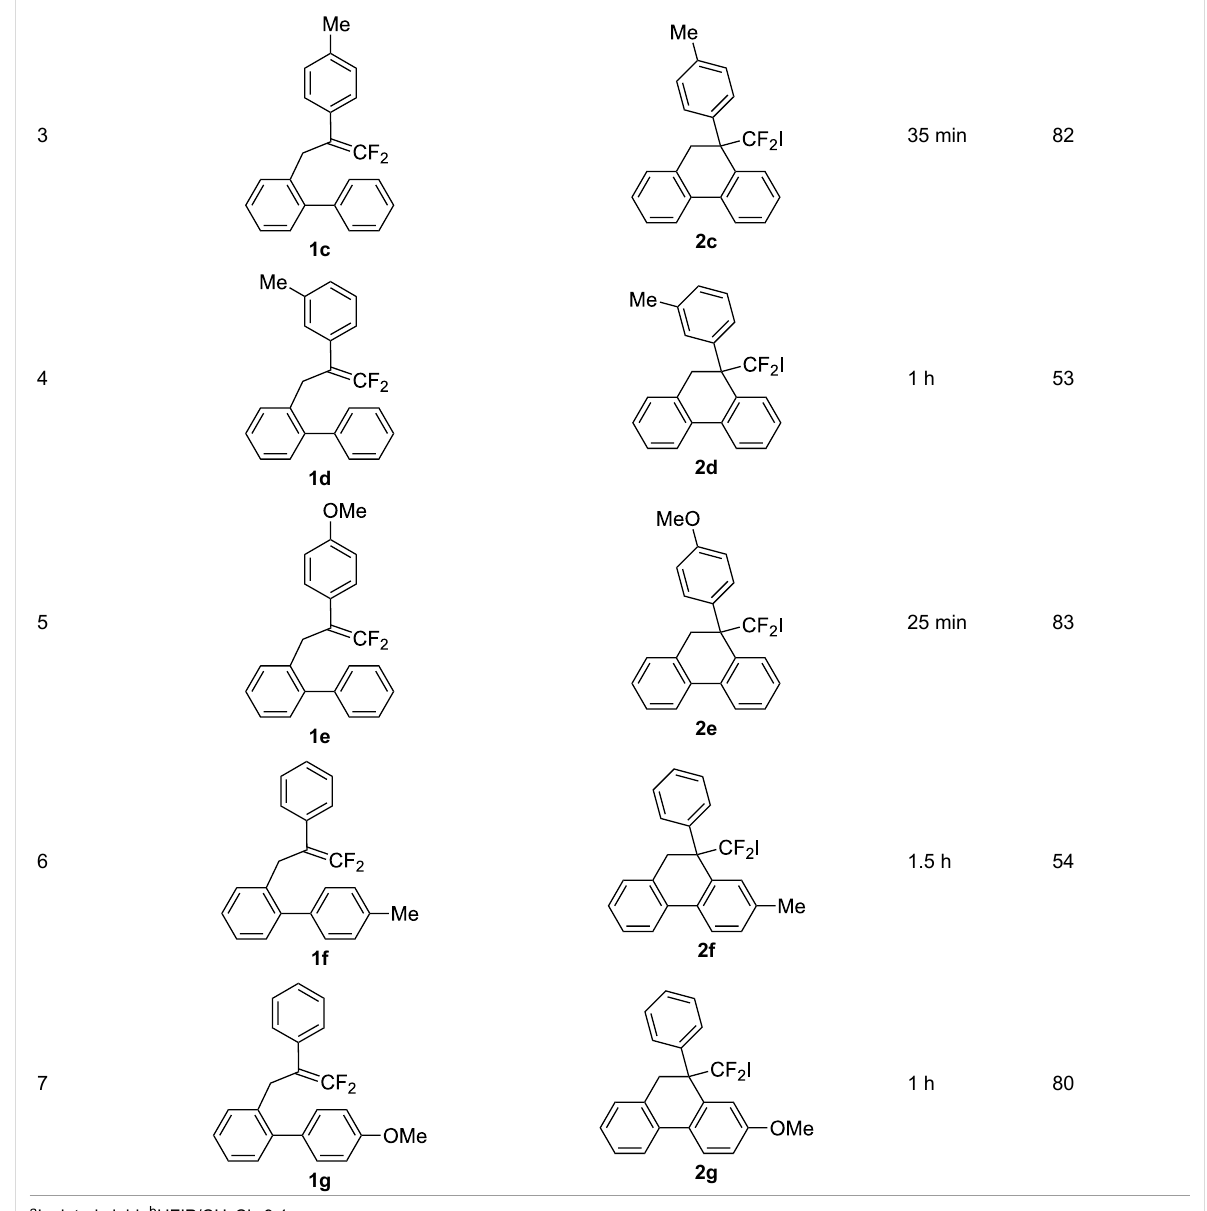
Table 2: Construction of six-membered carbocycles via iodoarylation of 1 .